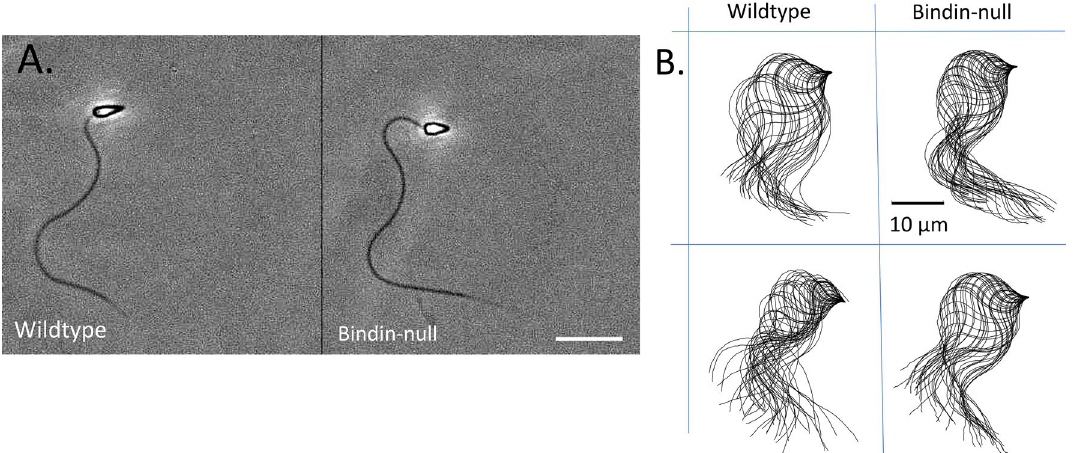
Figure 4. ( A ) Swimming sperm of wildtype (left) and Bindin-null (right) sperm from Hemicentrotus pulcherrimus . Image contrast has been enhanced using Image-J (ver.1.52a). Note that sperm from the Bindin- null sperm has similar head and tail morphometrics. ( B ) Flagellar profile from 45 successive traces of sperm. Note subtle variations between samples though essential profiles are consistent. Scale bars: 10